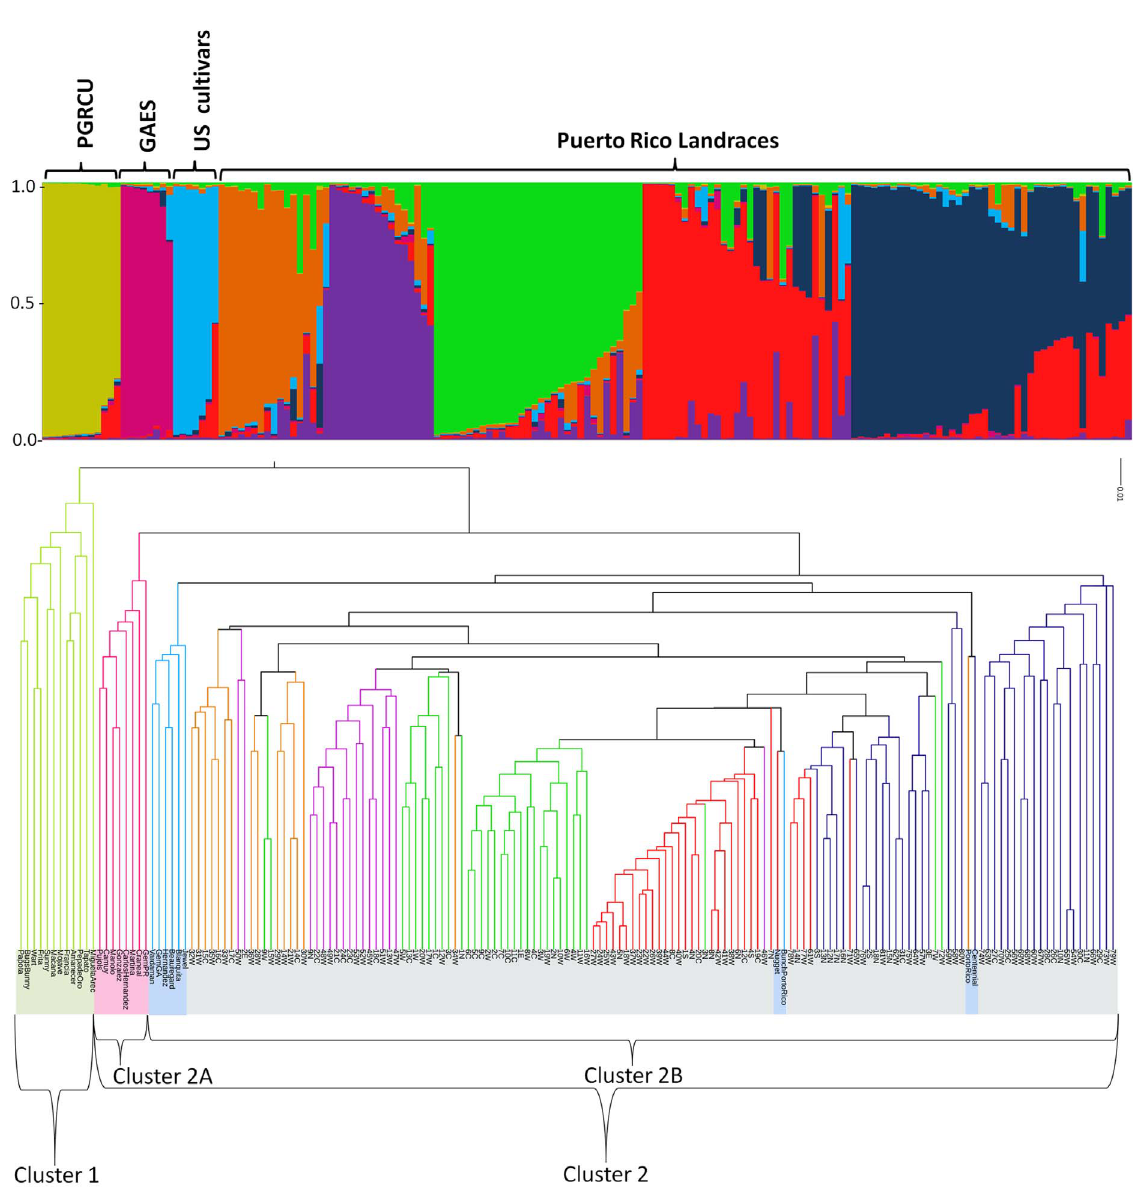
Fig. 3. Population structure and UPGMA clustering based on Euclidean distances of 167 accessions of sweet potato ( Ipomoea batatas ) analyzed with 23 SSR markers. Eight accessions are from the agricultural experimental station in Gurabo, Puerto Rico (GAES), 22 from the plant genetic resources conservation unit (PGRCU) in Griffin, GA (12 PR accessions and 10 known US commercial cultivars) and 137 Puerto Rico landraces across the island were analyzed. The eight groups (Group 1: olive green, Group 2: pink, Group: navy blue, Group: orange, Group: purple, Group: lime green, Group: red, and Group: blue) were determined based on STRUCTURE and Evanno et al . [26] analysis. The colors of the branches in the dendrogram also indicates the groups while the highlight of the name refers to PRGCU (olive green), GAES (pink), US cultivars (navy blue) and PR landraces (light